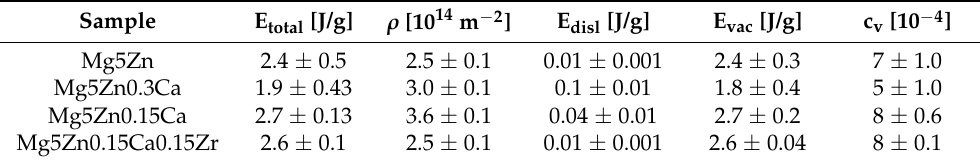
Figure 9. A representative heat flow curve as function of the temperature, for warm HPT-processed Mg5Zn0.3Ca exhibiting two exothermal peaks I and II. The thin red line is qualitatively similar to the base line which has been recorded in a second differential scanning calorimetry (DSC) run (for details see Section 2.4.3). Table 5. Measured and calculated data for DSC peak I. ρ is the dislocation density (measured), E disl is the dislocations’ stored energy calculated from ρ , and c v is the vacancy concentration (calculated).